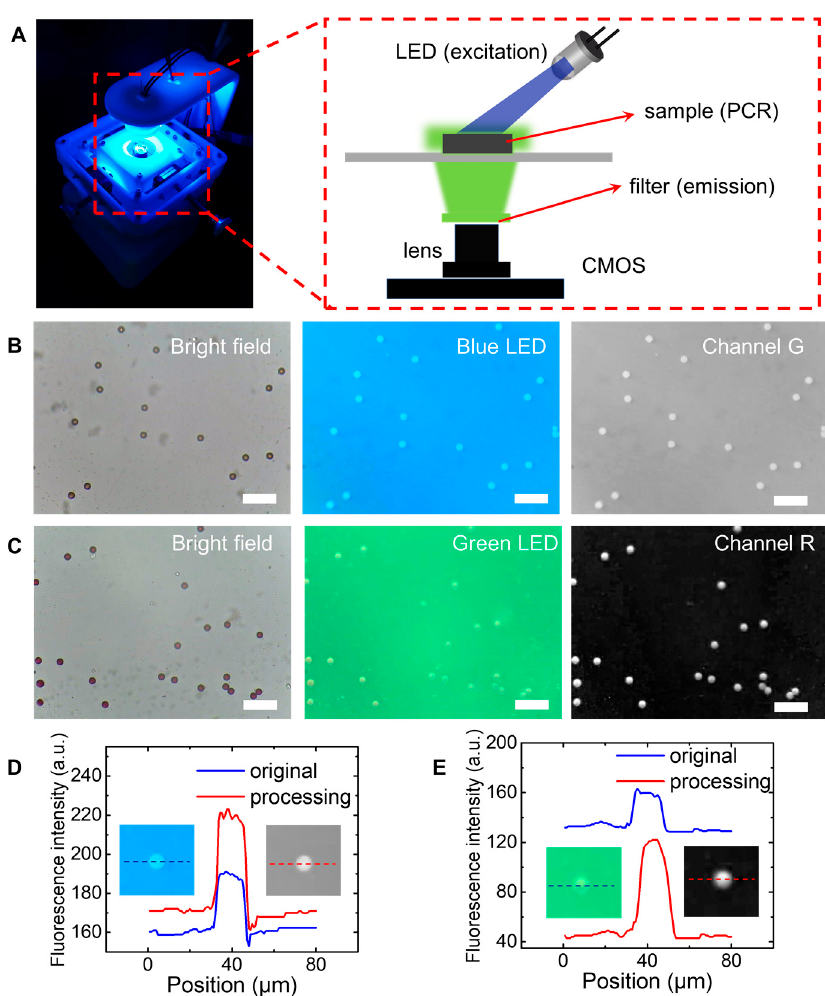
Figure 4. Performance of our portable microscopic device in fluorescence mode. ( A ) Working prin- ciples of fluorescence imaging of our device. ( B ) Microscopic images of green polystyrene particles using write LED and blue LED as light source. From left to right, are images from bright-field, blue LED field, and green channel. ( C ) Microscopic images of red polystyrene particles using write LED and green LED as light source. From left to right, are images from bright-field, green LED field, and red channel. ( D ) Fluorescence intensities from RGB images compared with green channel only. ( E ) Fluorescence intensities from RGB images compared with red channel only. Scale bars are 100 μ m.